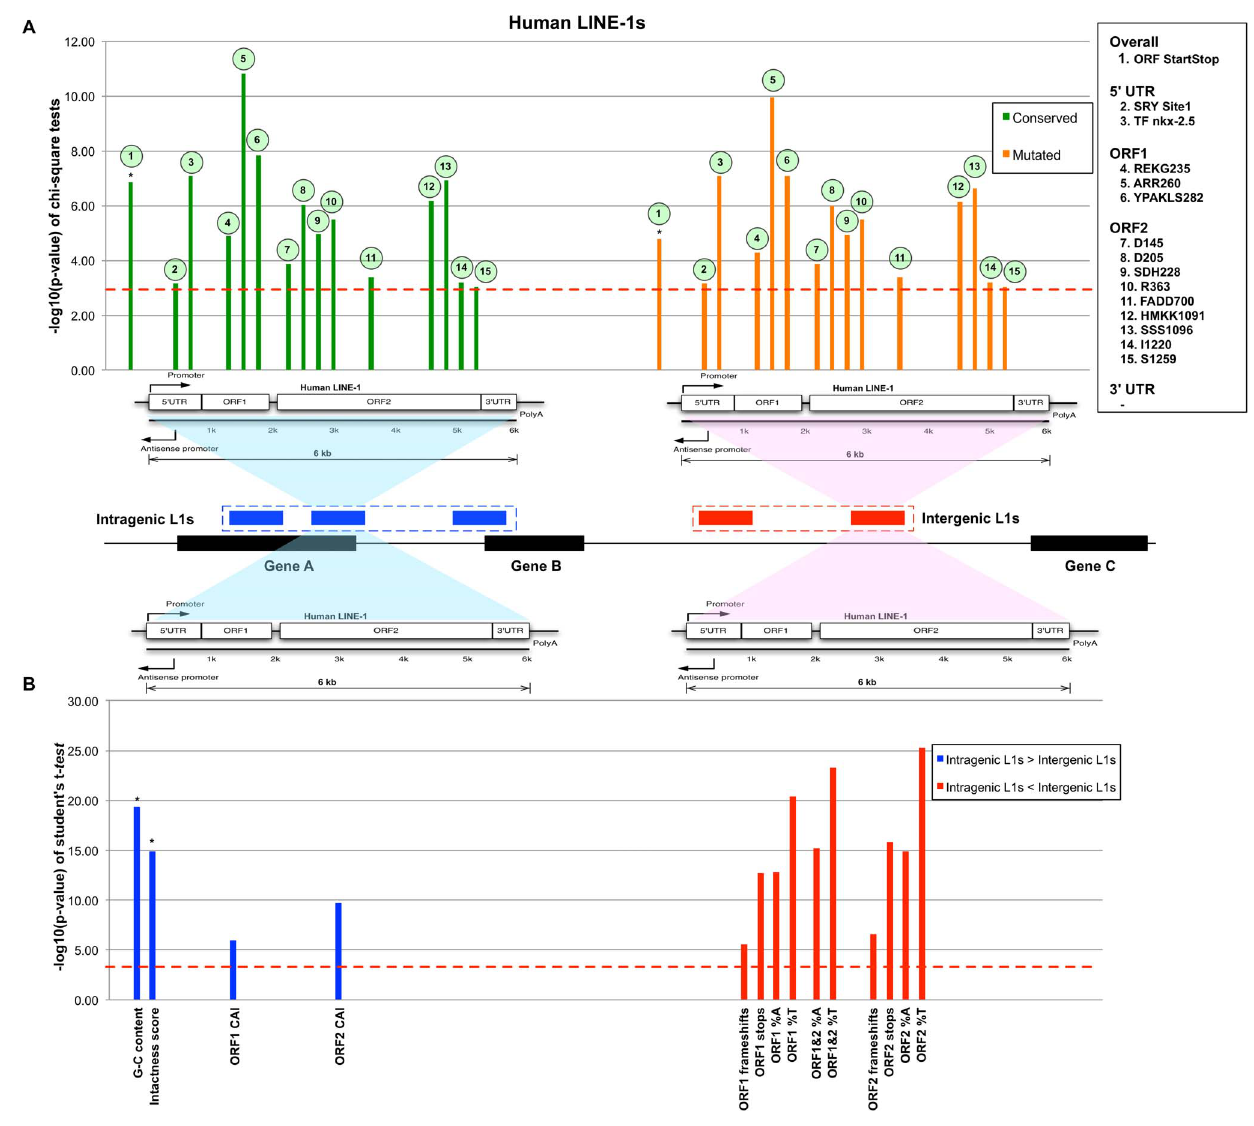
Figure 3. The comparison between intragenic and intergenic human L1s. (A) A bar graph shows 15 significant features passing the significance p-value 1.0E-03 (dashed line) from Mantel-Haenszel chi-square tests. The green and orange bars represent conserved and mutated features, respectively. These colored bars are aligned with L1 structure shown below the graphs. The bars marked with an asterisk (*) indicate the features calculated for the entire L1 sequence. (B) A bar graph shows non-categorical features whose significance p-value pass 1.0E-03 (dashed line). The blue columns indicate that more of these features appear in the intragenic L1s than that of intergenic ones. The red columns indicate that there are more of such features in the intergenic L1s than that of intragenic